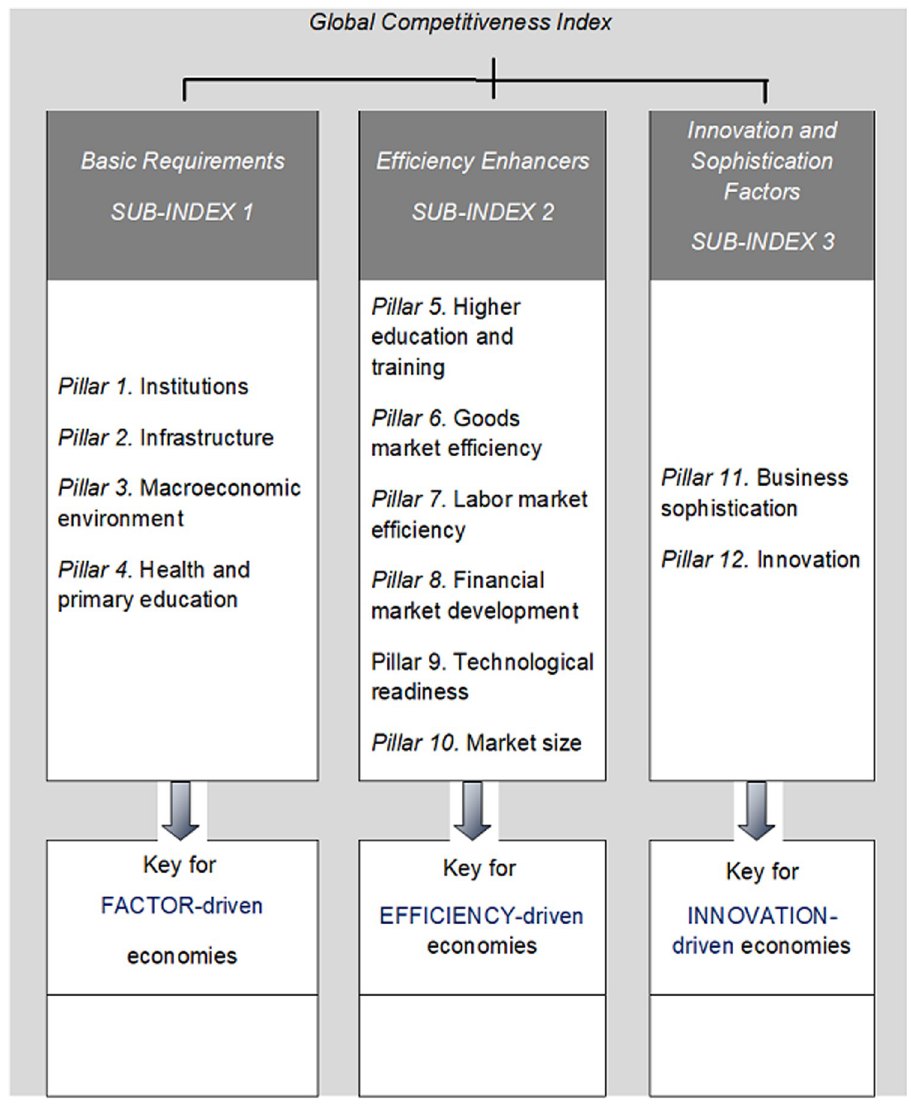
Fig 1. Groups of pillars in the global competitiveness index. Source: Fig 1 corresponds to a figure included, for example, in the 2010–11 Report [19, p. 9].